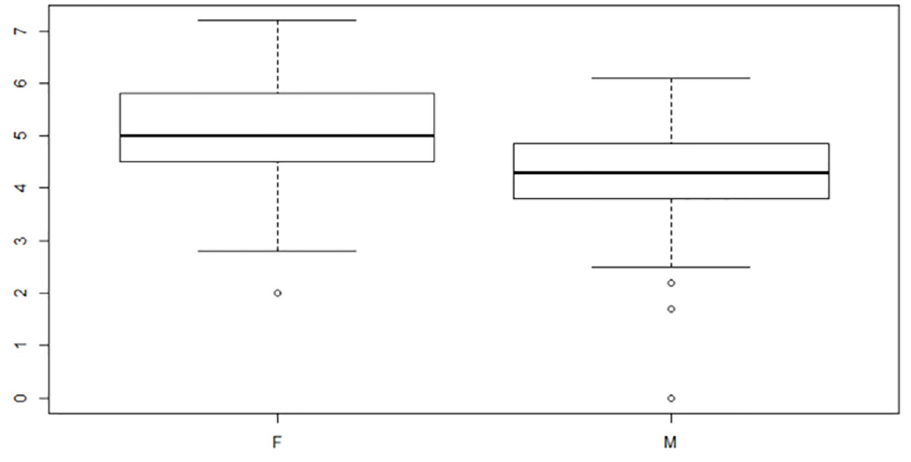
Fig 6. Distribution of average scores. Box plot comparing male and female average